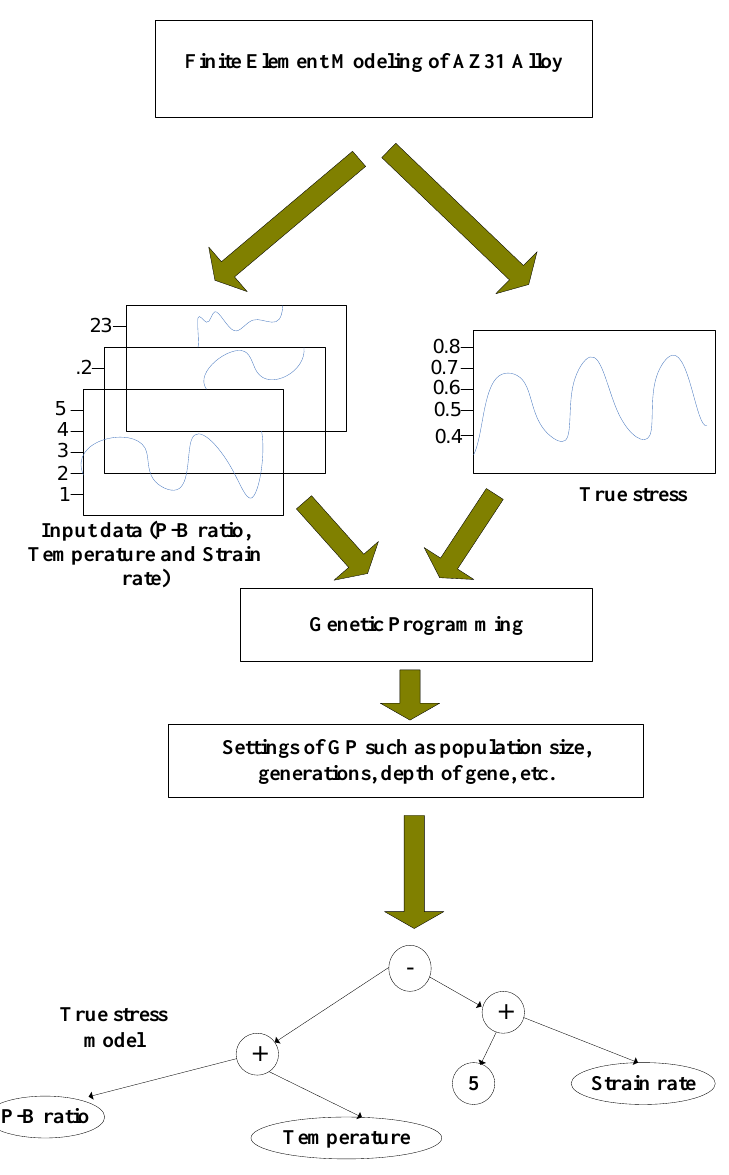
Figure 2. FEM-GP approach in modeling corrosion mechanics of AZ31 alloy. FEM-GP: Finite Element Modeling-Genetic Programming; P–B ratio: Pilling–Bedworth ratio.